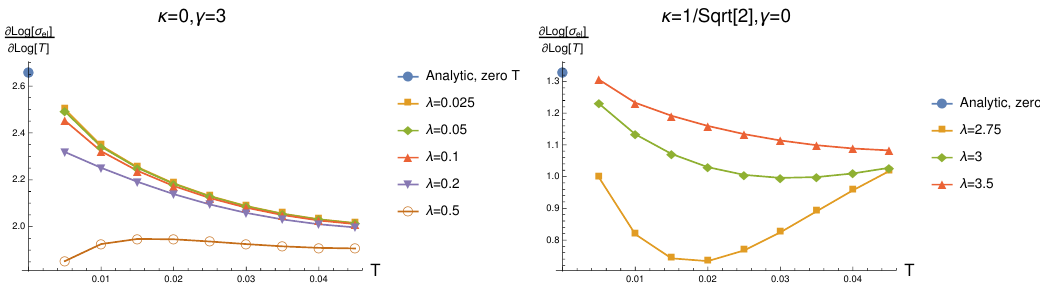
Figure 4 . Low temperature scaling of DC electric conductivity. The logarithmic derivative shows how close the data is to a pure power law. Left panel: pinned spontaneous states with p=(cid:22) = 1, (cid:13) = 3, (cid:20) = 0 and a range of (cid:21) . The states with small explicit source (cid:21) clearly asymptote to an analytic value 8 = 3, (4.2) at low temperatures. As (cid:21) grows the irrelevant deformation (4.3) starts playing the leading role and the low temperature scaling changes. Right panel: relevant explicit p case with p=(cid:22) = 1, (cid:20) = 1 = 2 and a range of (cid:21) . All the states tend to the same asymptotic scaling 4 = 3, predicted analytically at small temperature